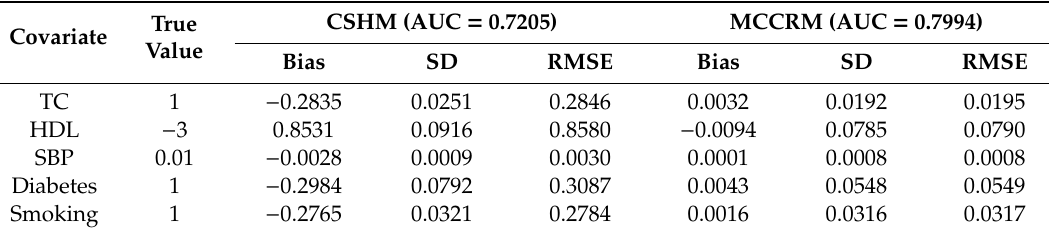
Table 6. Comparisons of the two models of